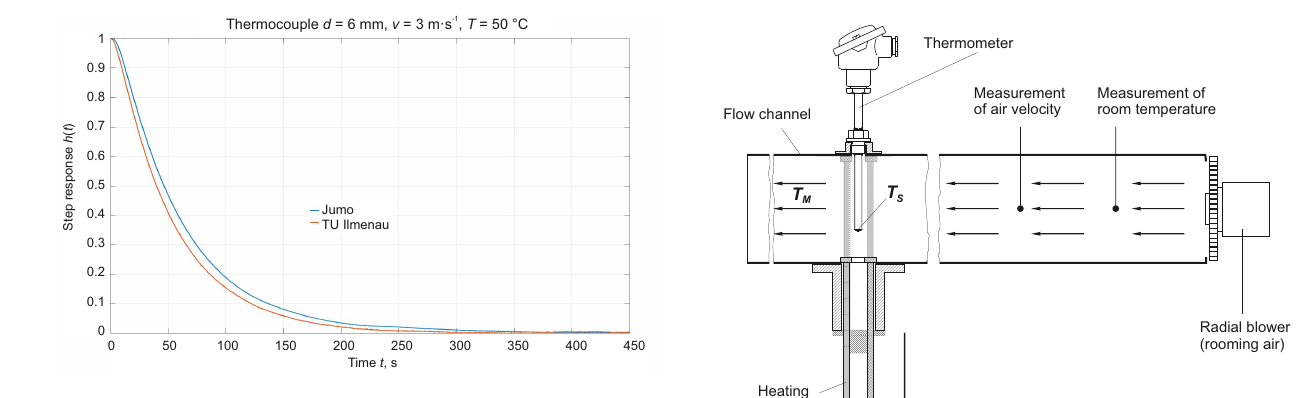
Figure 3. Example of a measured standardized step response in the air channel.